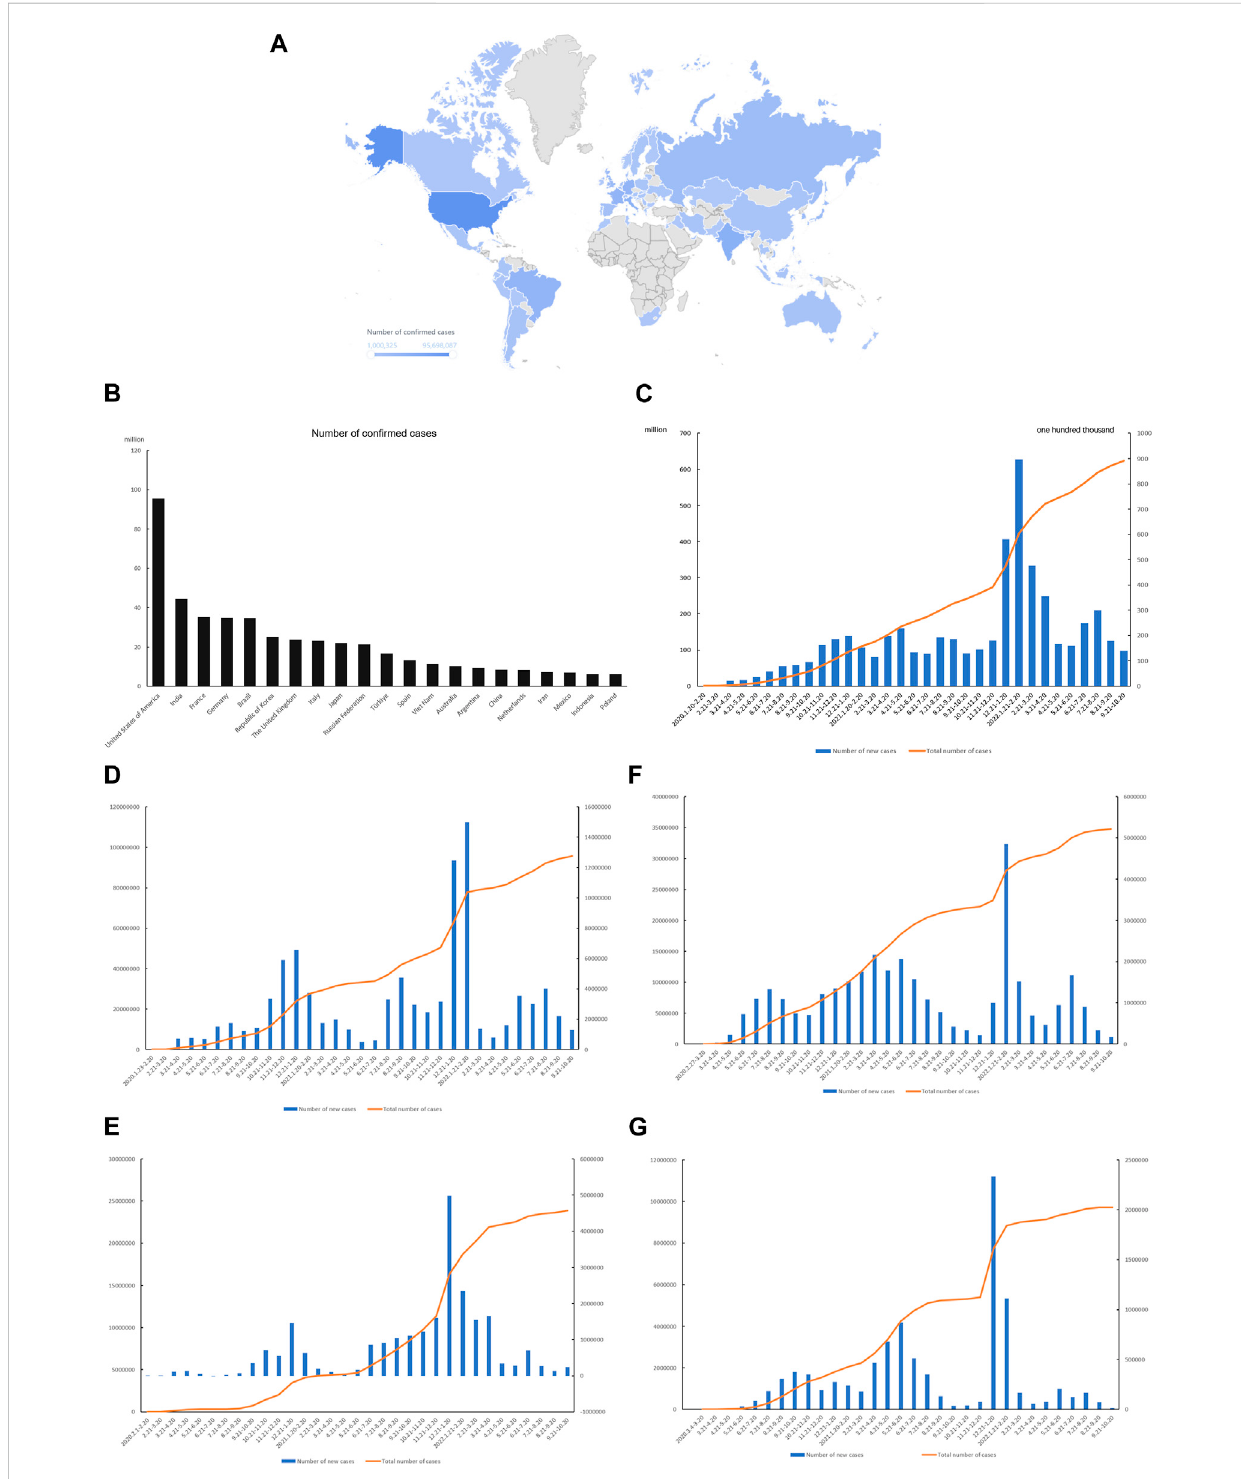
FIGURE 3 Trends of virus outbreaks in the past 2 years and possible seasonal correlations. (A) Map of countries with more than one million cases worldwide (43); (B) The top 20 countries in the world for con fi rmed cases; (C) Global case growth trend; (D) Increasing trend of cases in U.S.; (E) Increasing trend of cases in Britain; (F) Increasing trend of cases in Brazil; (G) Increasing trend of cases in